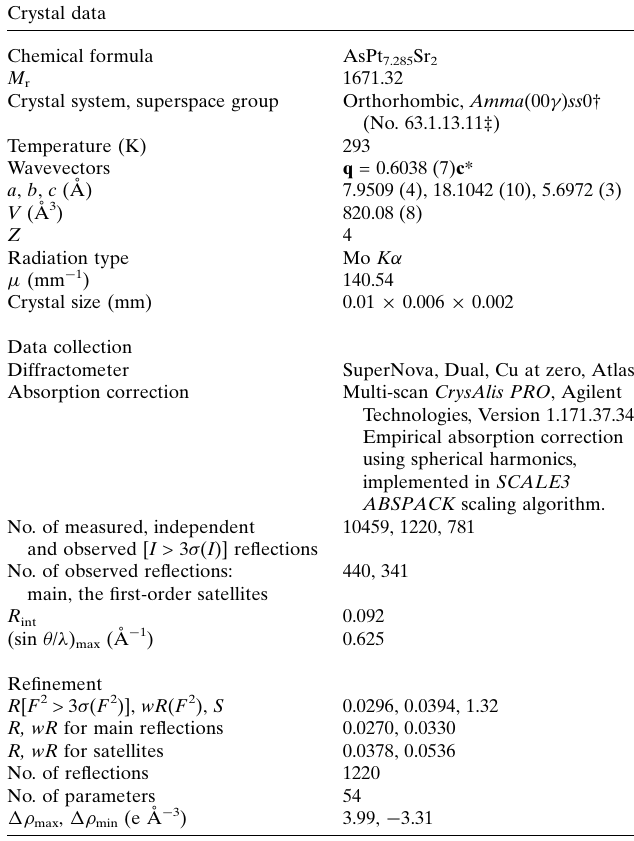
Table 2 Results of the X-ray study of Sr 2 Pt 8 (cid:2) x As [ x = 0.715 (5)]. Crystal